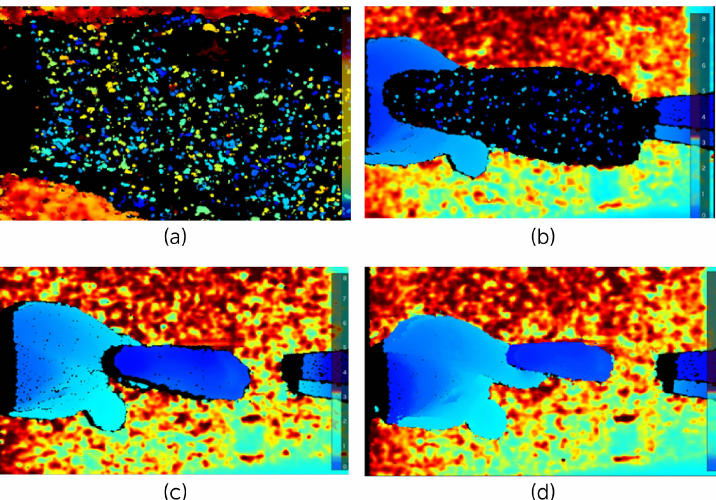
Fig. 11 Optimal distance from sensor trial, (a) 10cm, (b) 20cm, (c) 30cm, (d)